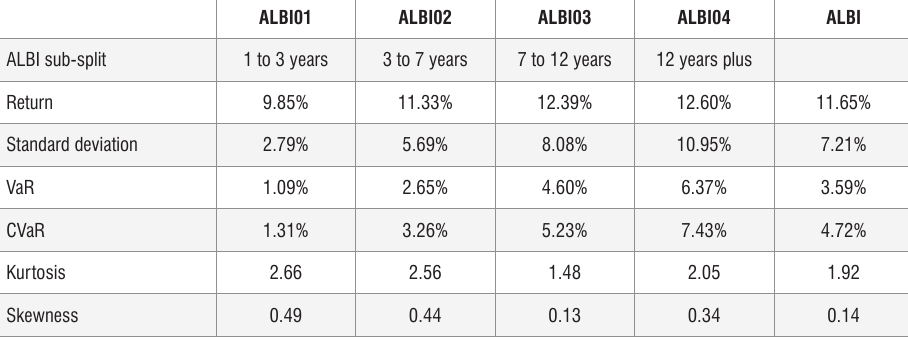
All Bond Index (ALBI) and sub-index risk and return